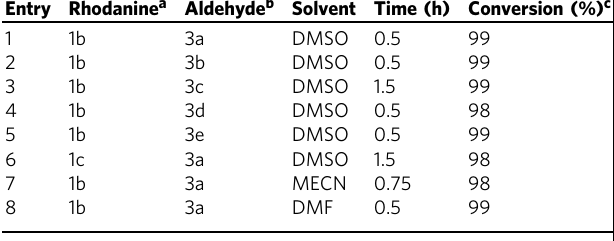
Table 2 The results of Knoevenagel reactions between various rhodanine with aldehyde